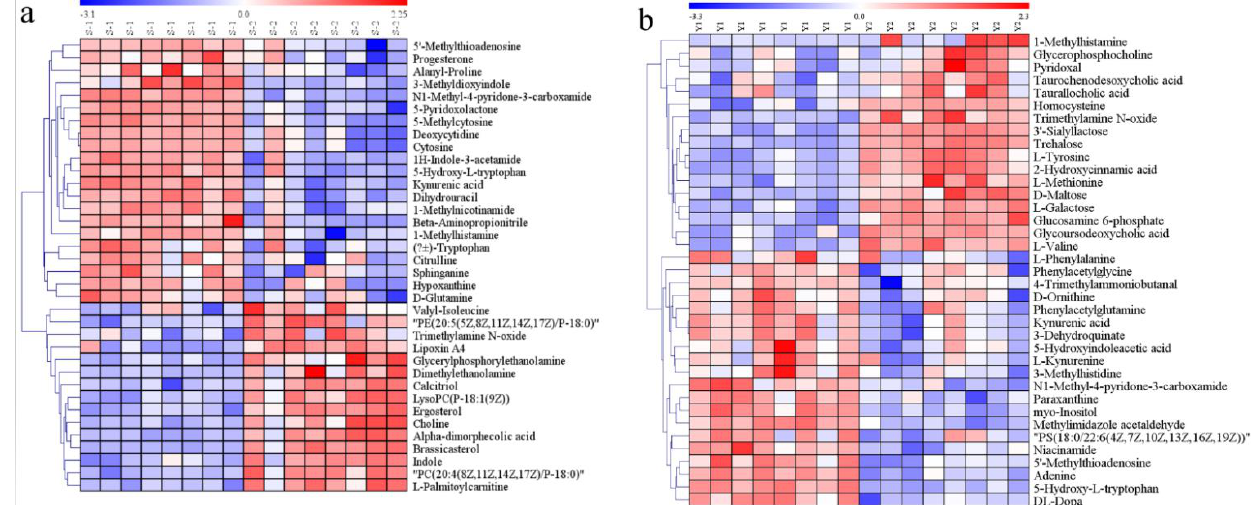
Figure 4. Heat map of differential metabolites analyzed by the hierarchical clustering analysis for serum and AF samples from CON and GDM groups. The horizontal axis represents samples and the vertical axis represents metabolites. Red and blue represent increased and reduced concentrations of metabolites in the GDM group compared with CON. ( a ) The heat map of 36 differential metabolites analyzed by the hierarchical clustering analysis in serum samples. ( b ) The heat map of 37 differential metabolites analyzed by the hierarchical clustering analysis in AF samples. S1: serum samples in CON; S2: serum samples in GDM; Y1: AF samples in CON; Y2: AF samples in GDM.